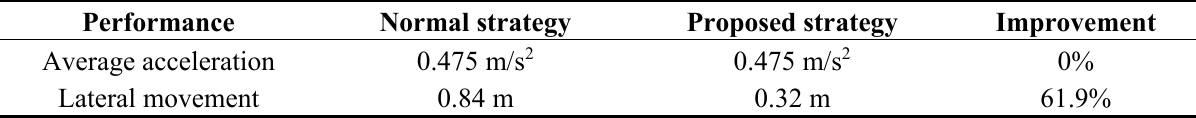
Figure 21. Comparison of the experimental results of the proposed strategy and normal strategy on a varying split- μ road: ( a ) lateral movement and ( b ) acceleration performance. Table 10. Driving performance comparison on a varying split- μ road